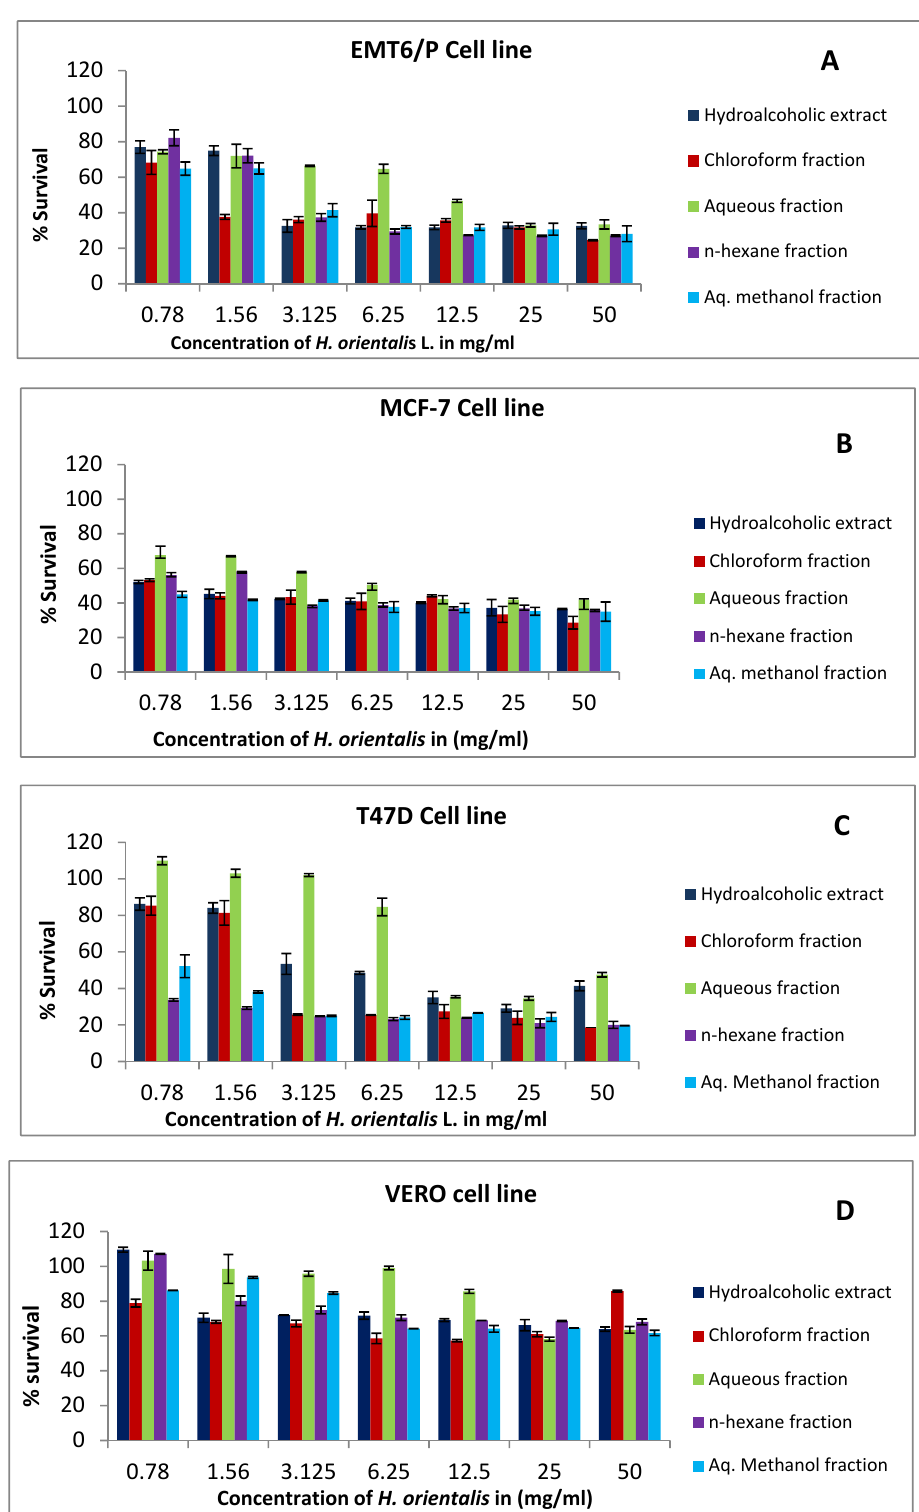
Figure 1. The antiproliferative activity of H. orientalis L. extract and fractions against: ( A ) EMT6/P cell line, ( B ) MCF-7 cell line, ( C ) T47D cell line, ( D ) Vero cell line using concentrations between 0.78 to 50 mg/mL. Percentage of cell viability (%) was calculated as (OD of treated cells/OD of control cells * 100). Results are expressed as means of three independent experiments (bars) ± SEM (lines). Table 2. IC ₅₀ values of H. orientalis L. extract and fraction against different cell lines.